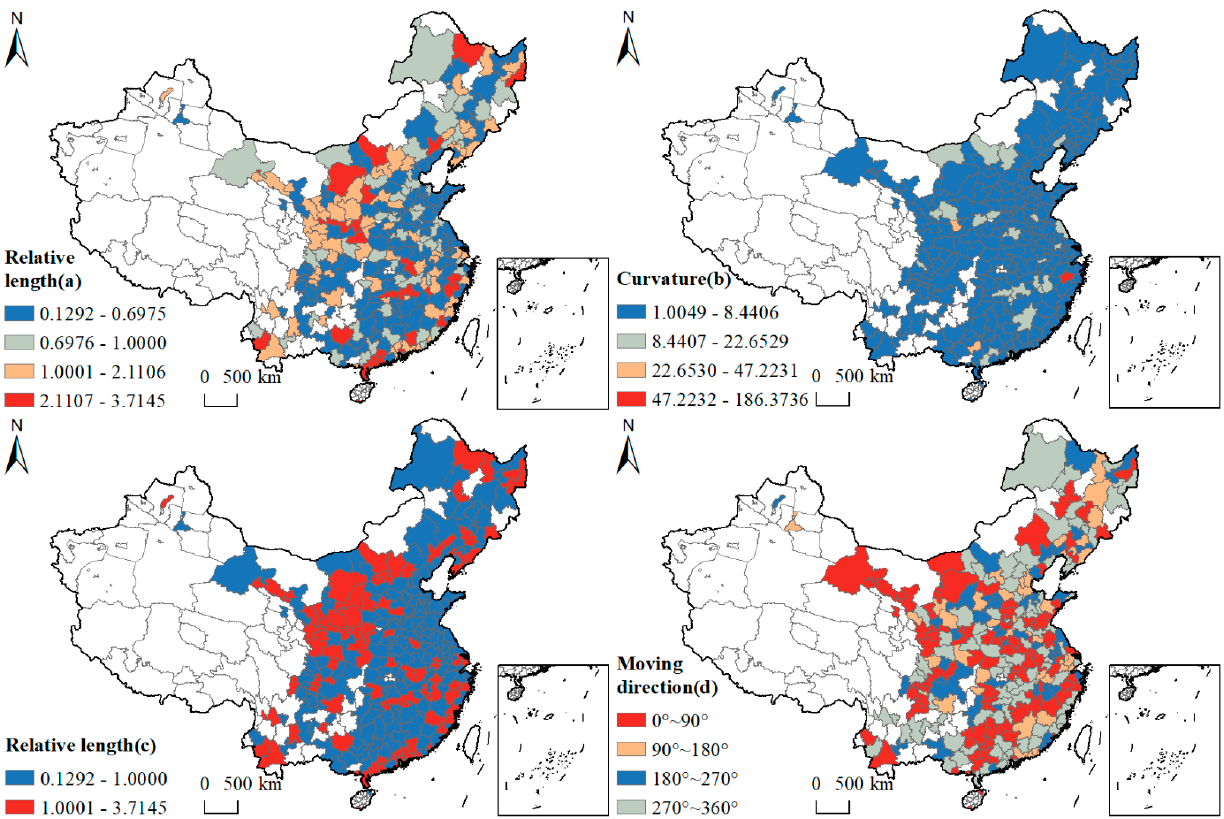
Figure 4. Spatial distribution of LISA time path characteristics of GLUEUL, 2005–2020. ( a ) Relative length; ( b ) Curvature; ( c ) Relative length; ( d ) Moving direction.